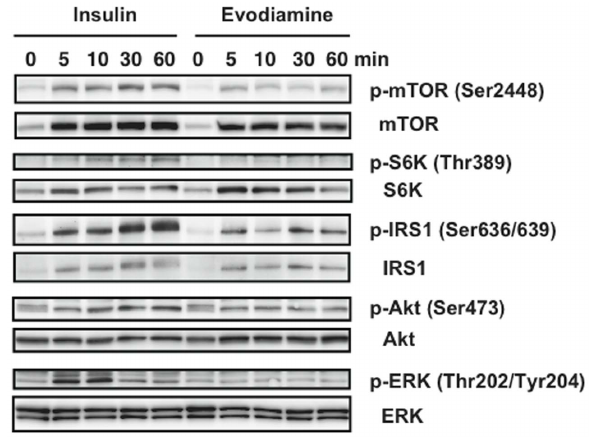
Figure 5. Effect of evodiamine and insulin on the mTOR-S6K signaling in differentiated adipocytes. After 3T3-L1 pre-adipocytes were differentiated into mature adipocytes, the cells were maintained in DMEM for 4 h and then stimulated by 20 nM insulin or 20 m M evodiamine for the indicated length of time. The cell lysates (15– 30 m g protein) were analyzed for phosphorylation of mTOR Ser2448, S6K Thr389, IRS1 Ser636/639, Akt Ser473 and ERK Thr202/Tyr204 by Western blot analysis. Representative images of two independent experiments are shown.